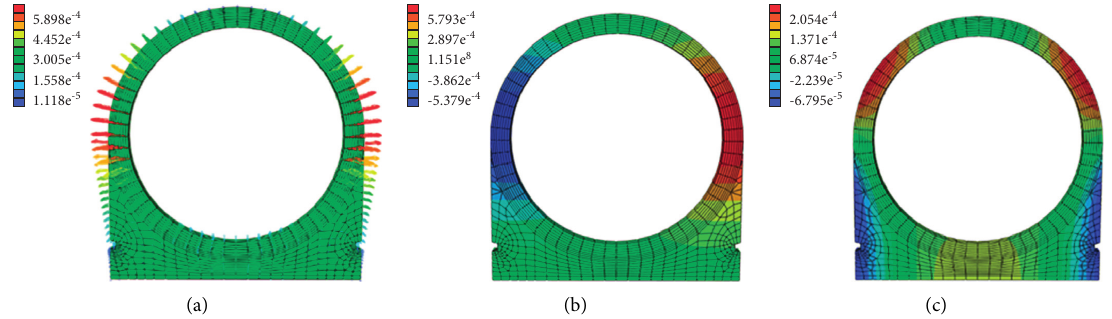
Figure 17: Incremental deformation of the prestressed culvert structure: (a) deformation vector diagram; (b) horizontal deformation; (c) vertical